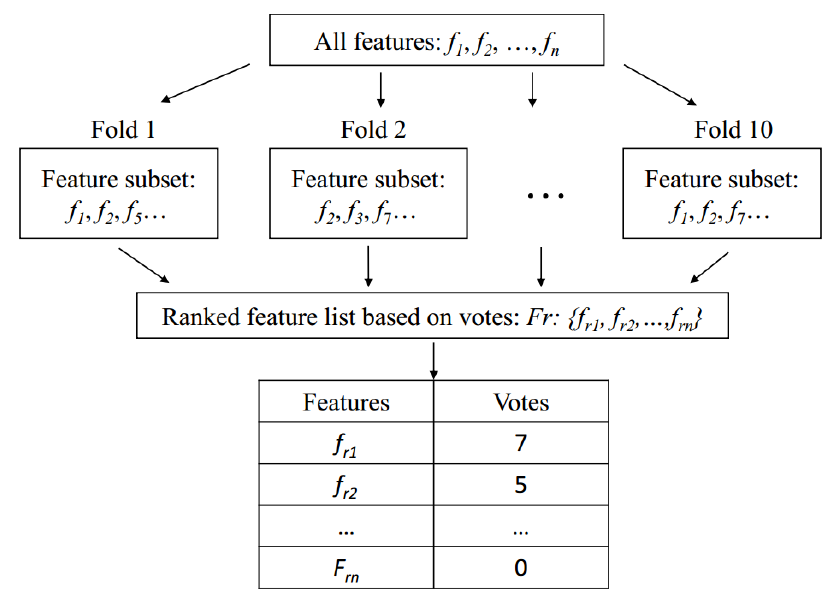
Figure 4. Voting strategy to select the optimal feature subset after the 10-fold cross-validation. Here, we assume that the top two ranked features have votes 7 and 5, respectively.